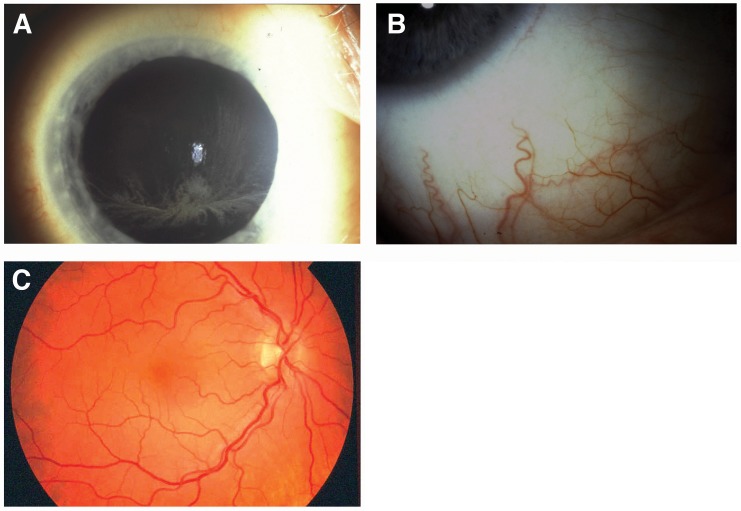
Representative ocular changes seen in patients with Fabry disease.Representative ocular changes include (A) cornea verticillata, (B) increased tortuosity of conjunctival vessels, and (C) increased tortuosity of retinal vessels.